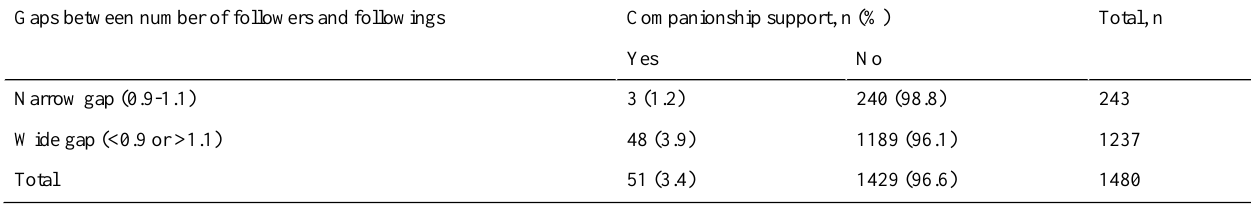
Table 3. Companionship support and gaps between number of followers and followings.